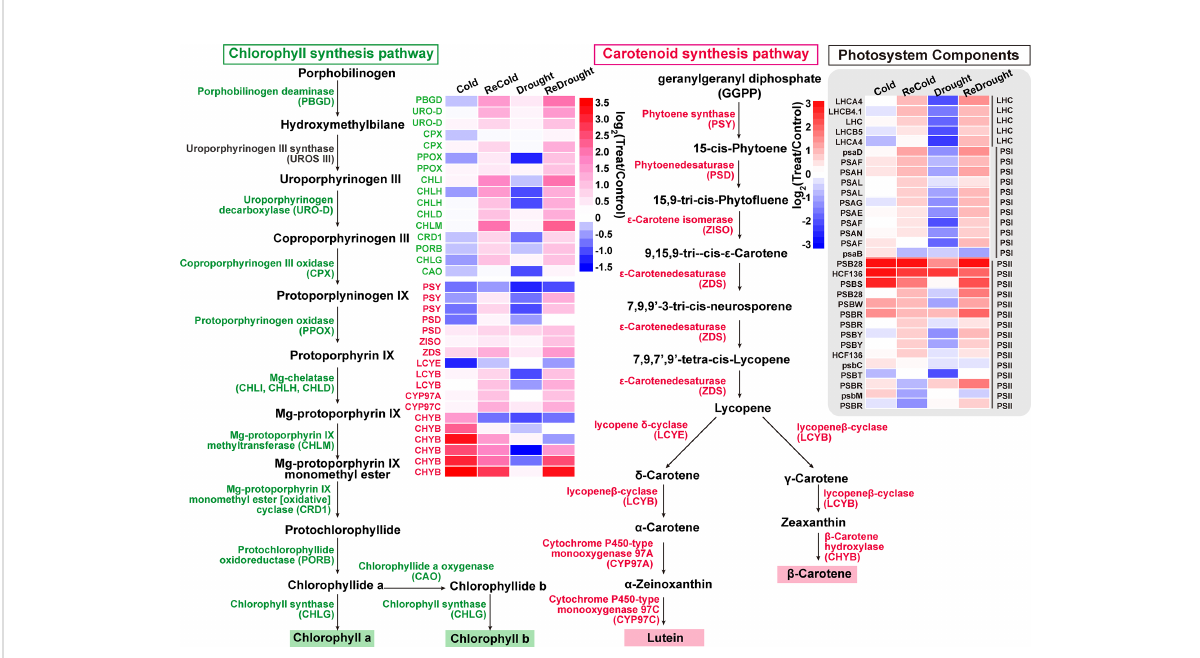
FIGURE 7 The components of photosynthetic pigment biosynthesis and photosystem. The expression changes of genes are denoted by heat maps, and the color intensity represents the expression